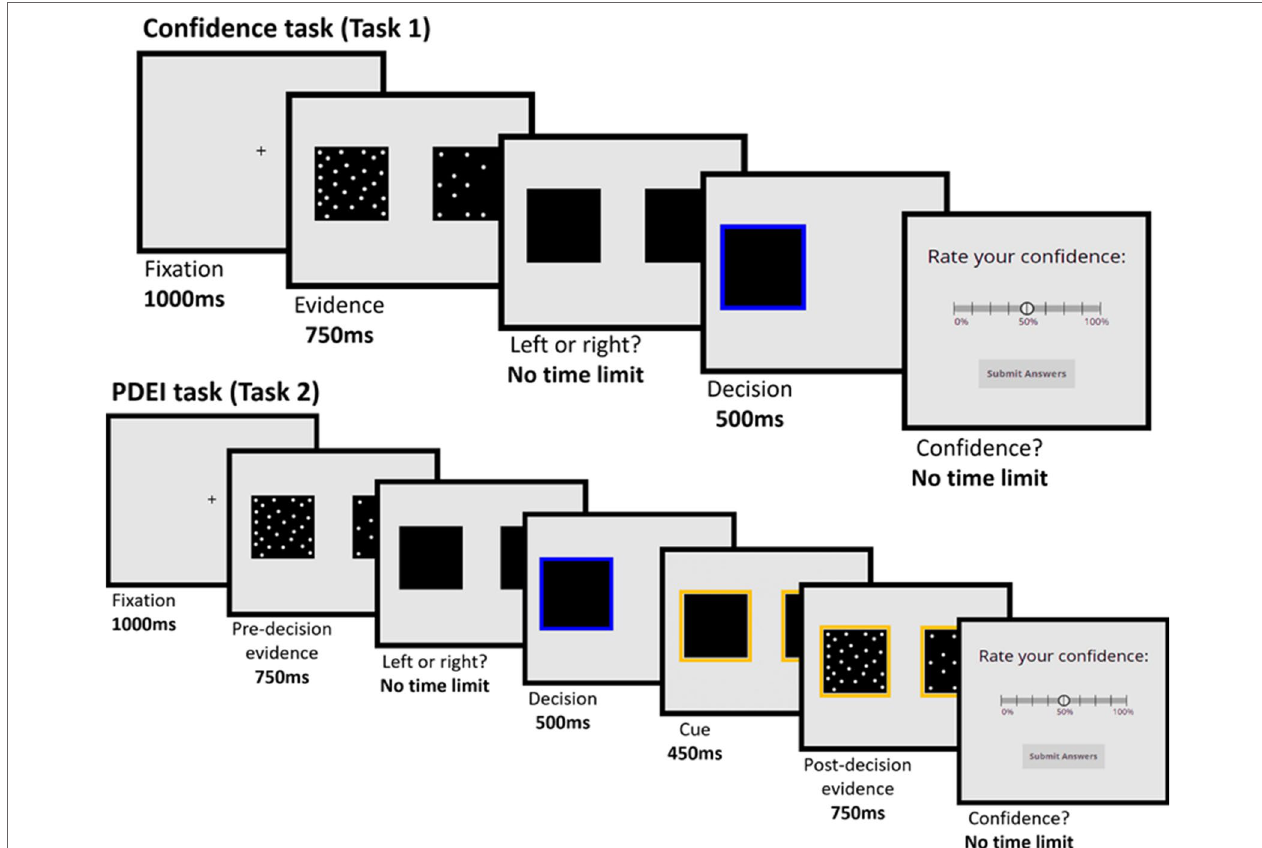
FIGURE 1 | Confidence task (Task 1) and Postdecision Evidence Integration (PDEI) task (Task 2). Participants were asked to judge which of two squares contained more flickering dots. In the Confidence task, participants immediately rated their confidence following their decision. In the PDEI task, participants viewed a new set of dots (always in the same direction as the predecision evidence. Half of trials showed evidence of the same strength as in predecision phase, whereas half of the trials showed evidence of greater strength) before rating their confidence in their original